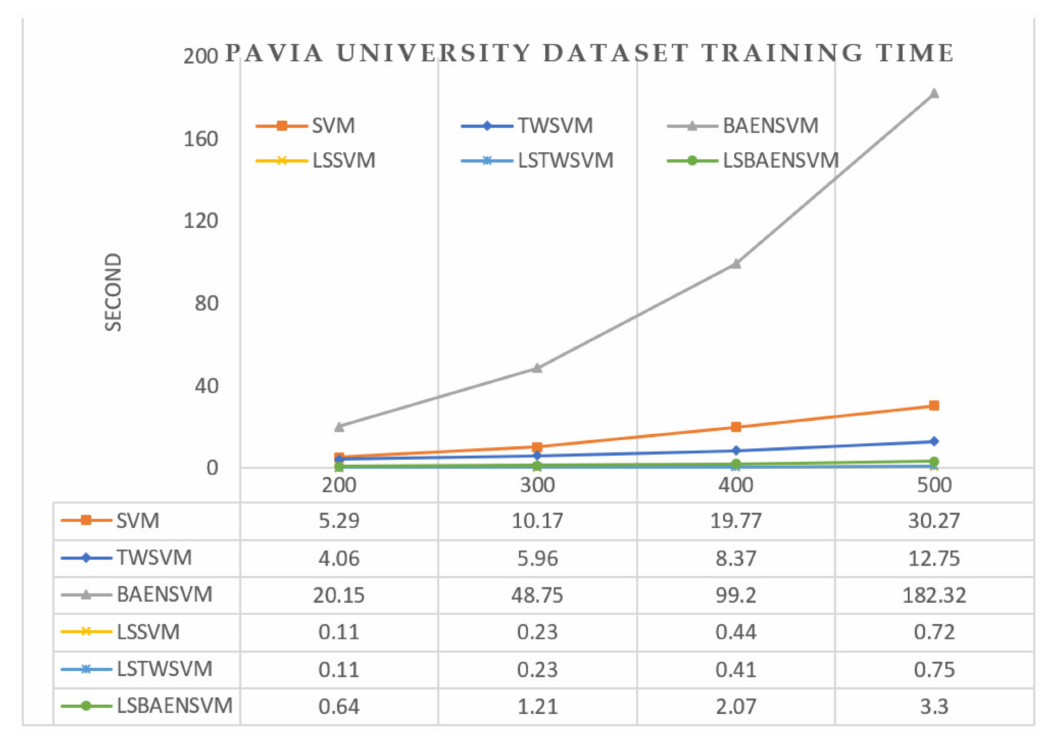
Figure 9. Time-consumption comparison of SVM, TWSVM, BAENSVM, LSSVM, LSTWSVM, and LSBAENSVM using different scales of Pavia University training